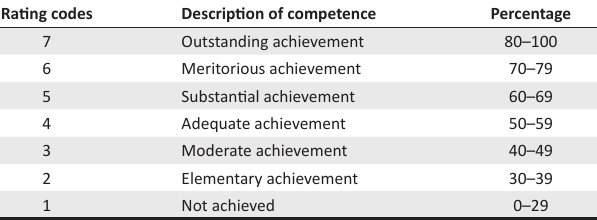
TABLE 1: Curriculum and Assessment Policy Statement framework for reporting assessment